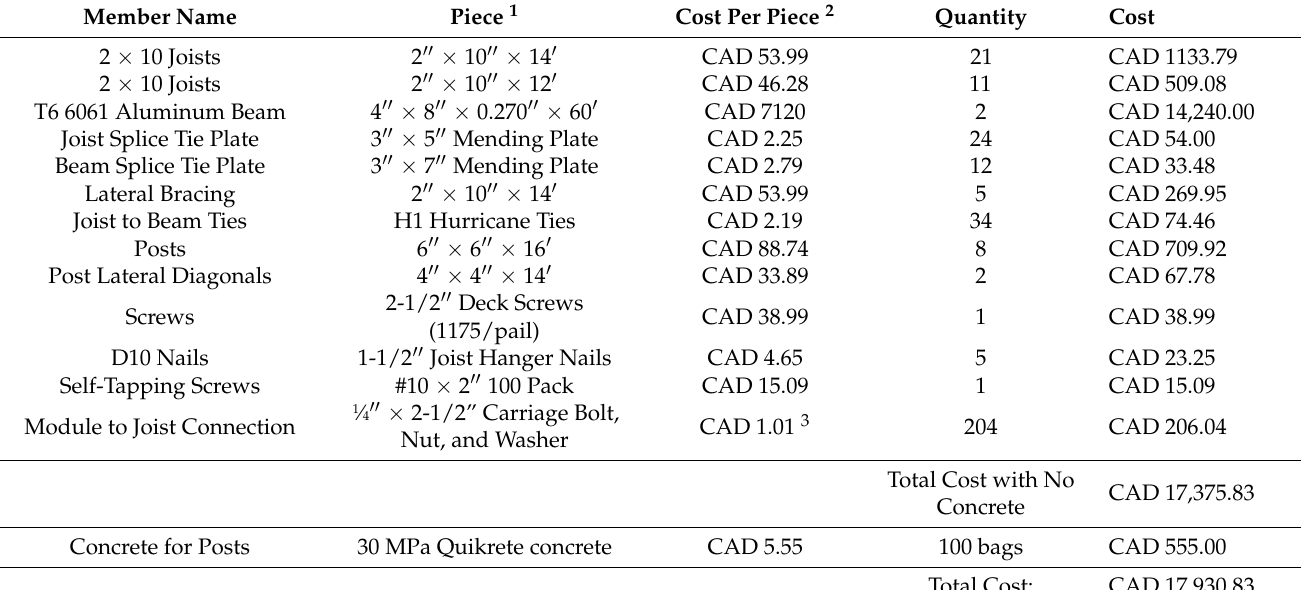
Table 5. Two-Span System Bill of Materials.